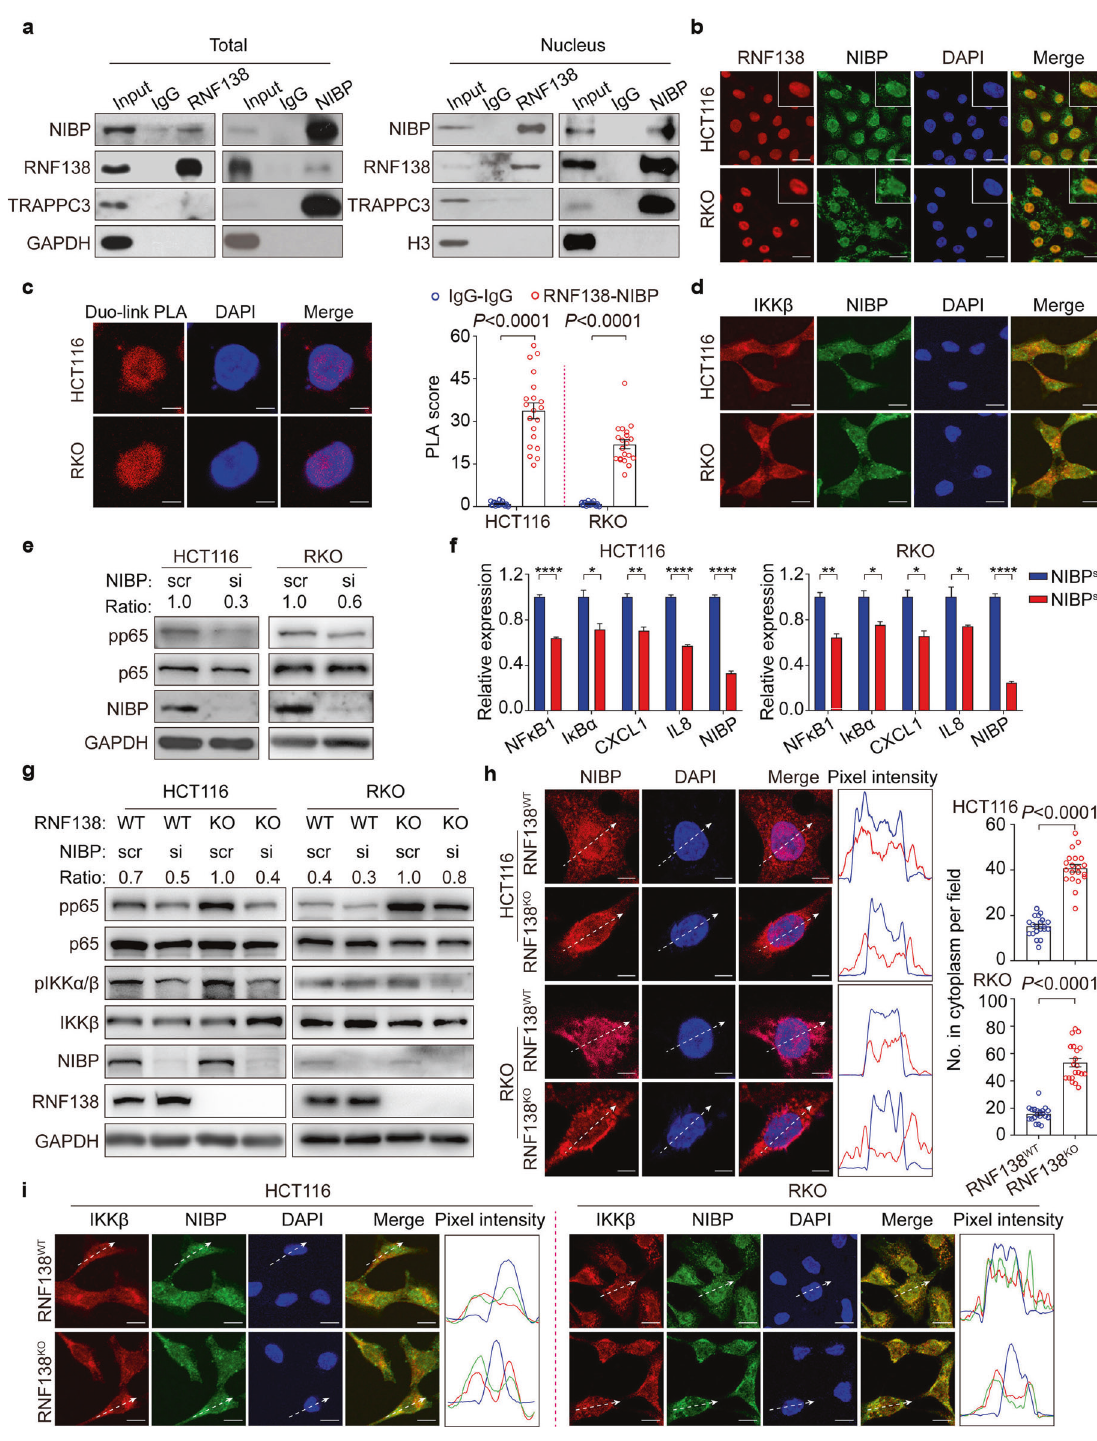
Fig. 4 Nuclear-cytoplasmic partitioning of NIBP is regulated by RNF138 and contributes to the activation of NF- κ B signaling. a Co-immunoprecipitation analysis of endogenous RNF138 and NIBP interactions in HCT116 total lysates (left) and nuclear extracts (right). IgG was used as control. b Immunostaining analysis of RNF138-NIBP co-localization in HCT116 and RKO cells. Nuclei were stained with DAPI. Insets show stained areas in more detail. Scale bar, 20 μ m. c Representative confocal images (left) and quanti fi cation (right, n = 20) of endogenous RNF138 and NIBP interactions in HCT116 and RKO cells using proximity ligation assay. IgG were used as controls. Scale bar, 5 μ m. d Immunostaining analysis of the co-localization of endogenous IKK β and NIBP in HCT116 and RKO cells. Scale bar, 5 μ m. e Immunoblots of phosphorylation, total levels of p65 in HCT116 and RKO cells transfected with si-NIBP or control siRNA. f qPCR analysis of NF- κ B target gene expression in HCT116 and RKO cells ( n = 3) with NIBP inhibition. *P <0.05; **P< 0.01 and ****P <0.0001. g Immunoblots of phosphorylation and total levels of p65 and IKK β in RNF138 WT and RNF138 KO HCT116 and RKO cells with NIBP inhibition. h Representative immunostaining images of NIBP localization in RNF138 WT and RNF138 KO HCT116 and RKO cells, and the distribution of relative fl uorescence intensities of lines scanned across the nucleus (right). Quanti fi cation of cytoplasmic NIBP intensity in HCT116 and RKO cells ( n = 20). Scale bar, 5 μ m. i Immunostaining analysis of IKK β -NIBP co-localization in RNF138 WT and RNF138 KO HCT116 and RKO cells and relative pixel intensity of lines scanned across the nucleus. Scale bar, 20 μ m Signal Transduction and Targeted Therapy (2022)